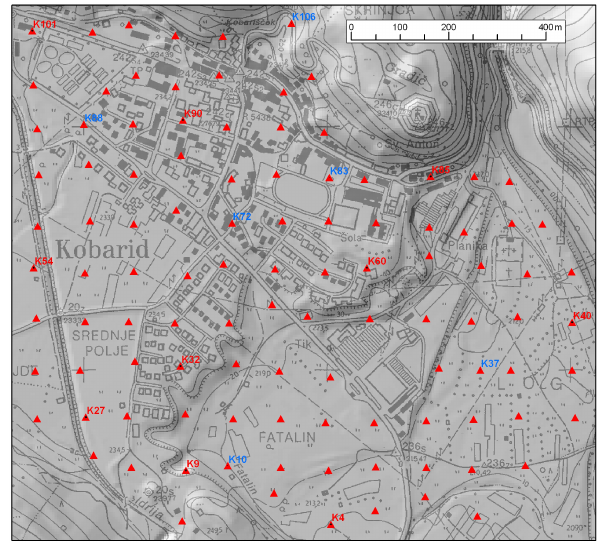
Fig. 2. Position map of microtremor free-field measurements (red triangles) in the Kobarid basin. Red labels indicates examples of HVSR analyses shown in Fig. 3 and blue labels examples shown in Fig.